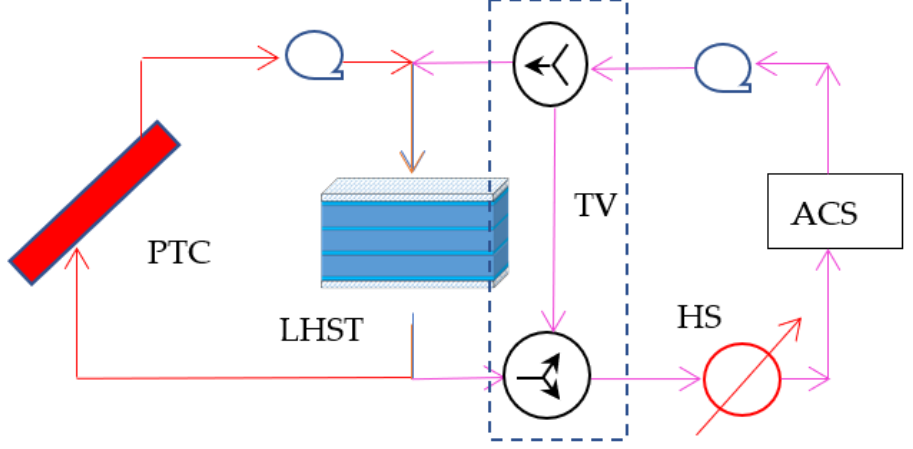
Figure 6. Solar cooling system with latent heat storage tank and a tempering valve.